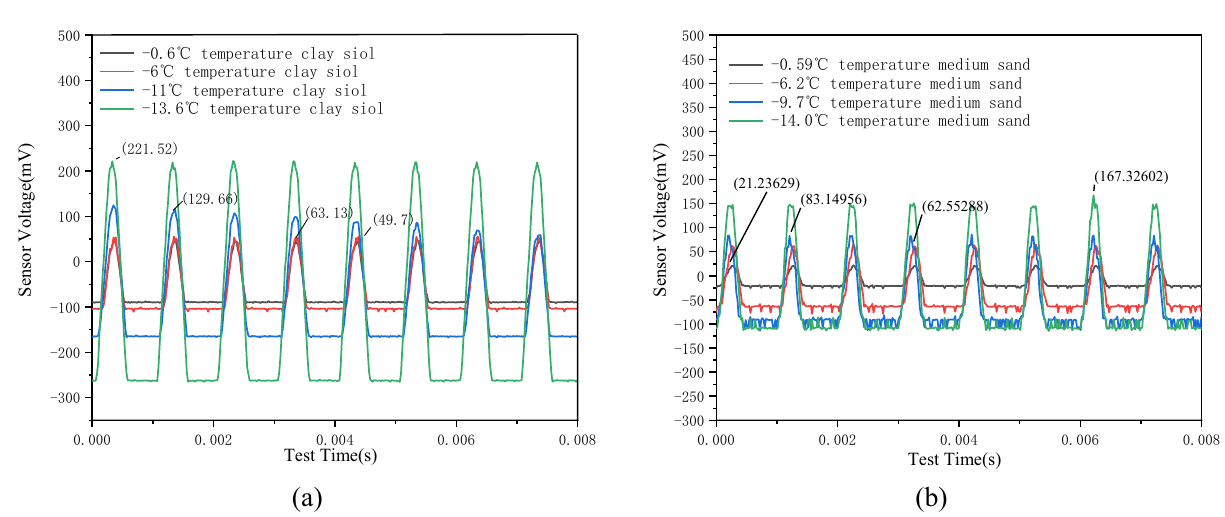
Figure 6. Sensing voltage changes of samples at different temperatures. ( a ) Sensor voltage variation diagram of clay samples at different temperatures. ( b ) Sensor voltage variation diagram of medium sand samples at different